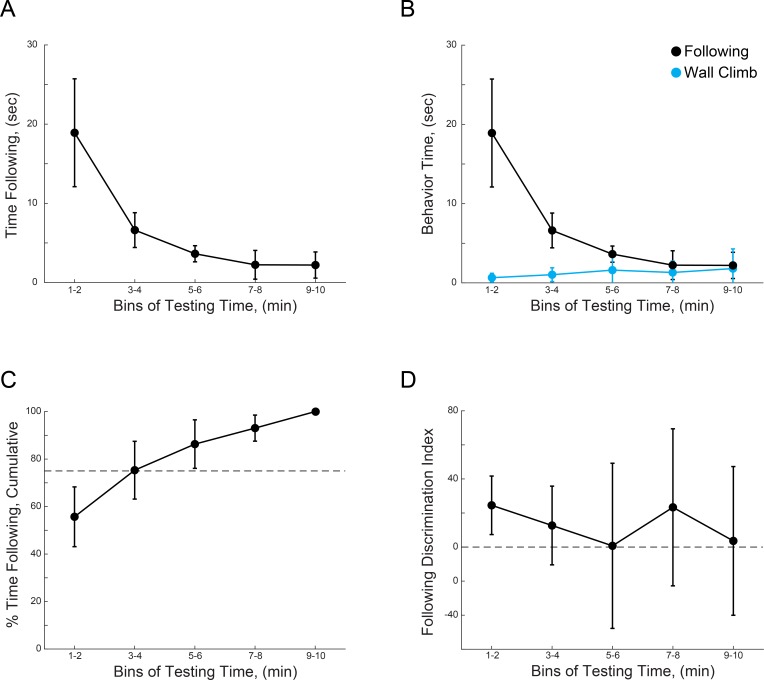
WT mice show preference for novel mice during the first 4 min of unrestricted interactions.(A) Time spent by test mice actively following sentinel mice over the total testing time. (B) Time spent by test mice actively following sentinel mice over the total testing time, plotted vs. the time spent by test mice investigating the chamber. (C) Cumulative percentage of following behavior over time, dotted line indicates 75%. (D) Discrimination index between novel and familiar sentinels over test time. (n = 10 WT mice).